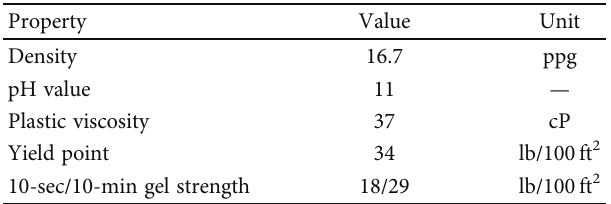
Table 2: The resulted key properties of the base drilling fl uid